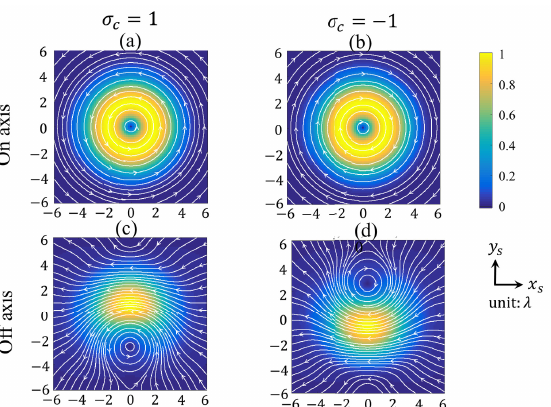
Figure 2. The transverse energy flux s xy with flow lines (in white) and strength | s xy | (color-coded) on the focal plane. Here ( a ) σ c = 1, a = 0 ( b ) σ c = − 1, a = 0, ( c ) σ c = 1, a = 0.5 w 0 and ( d ) σ c = − 1, a = 0.5 w 0 . In all plots: f = 2 mm, w 0 = 2 mm and α = 60 ◦ .